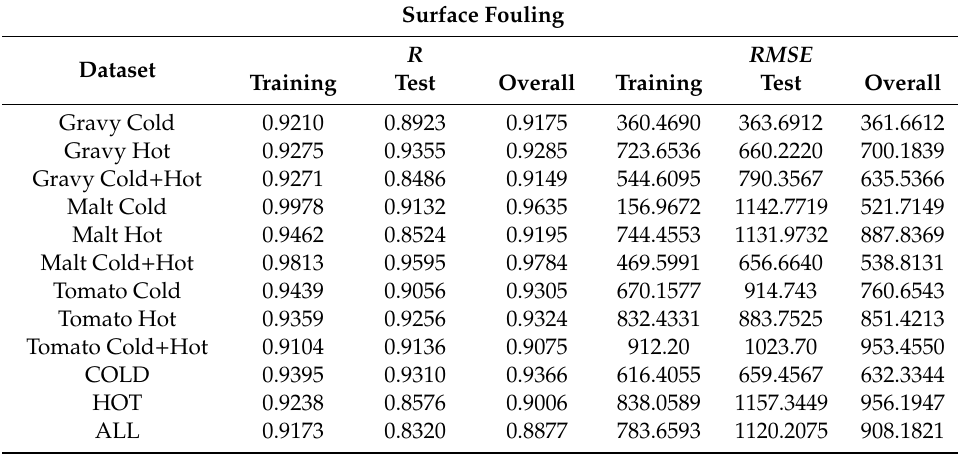
Table 2. Summary of surface fouling Neural Network (NN) regression results. RMSE: Root Mean Squared Error.